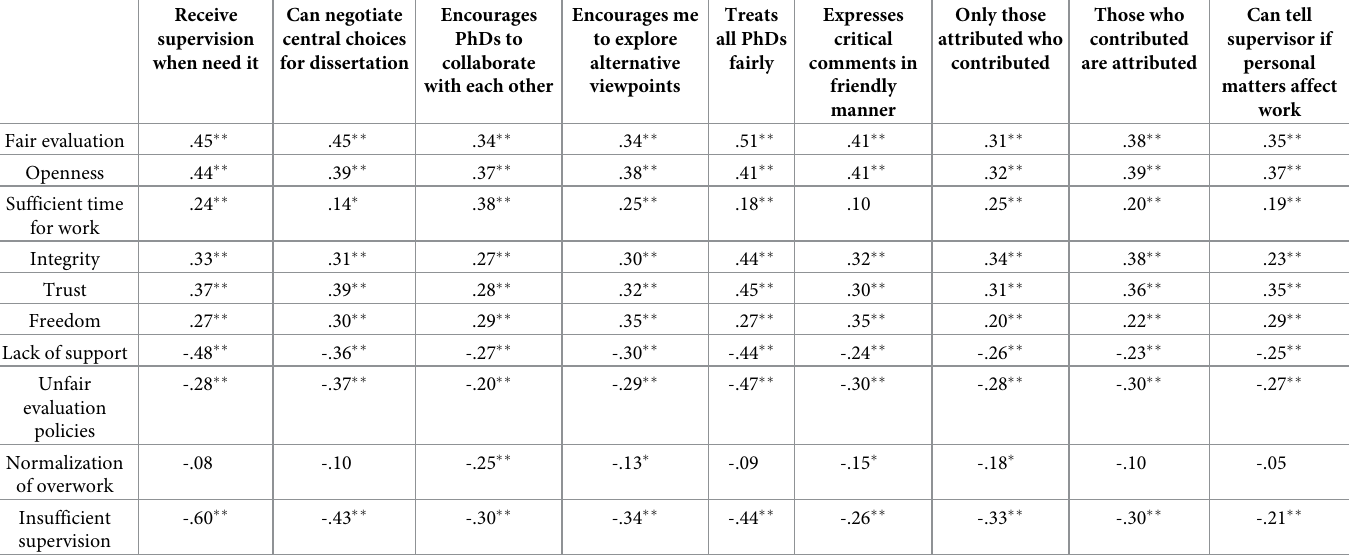
Table 4. Spearman correlations for research climate items and supervisory practices